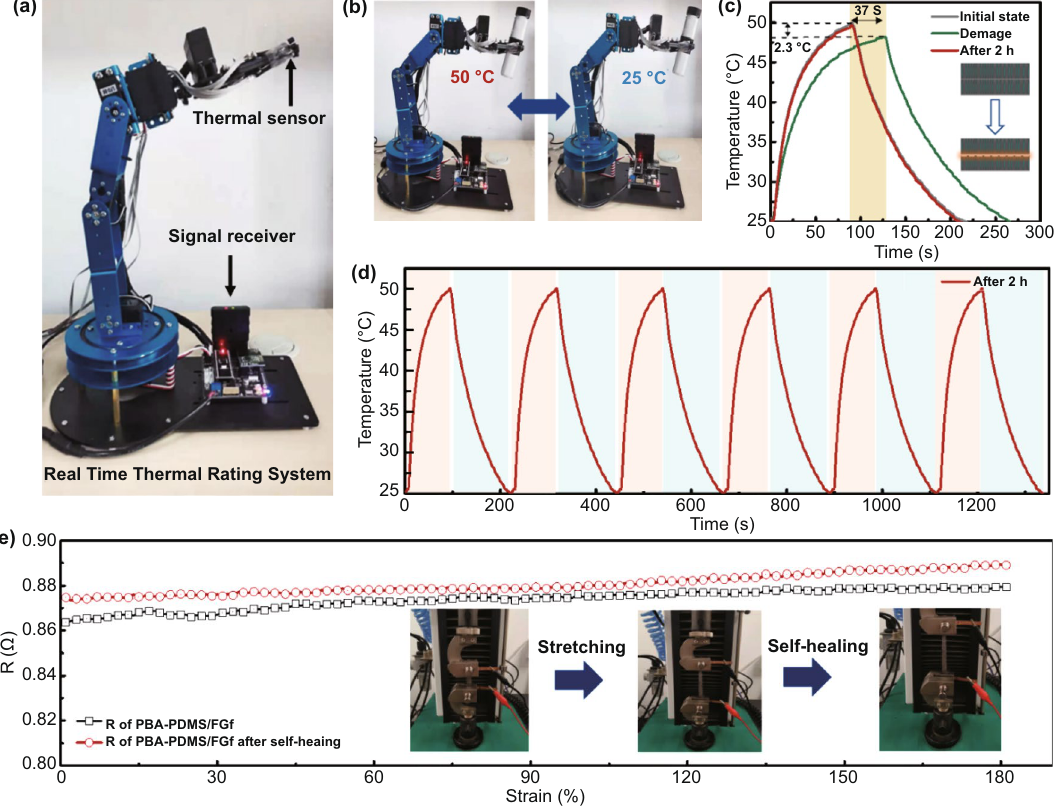
Fig. 6 a Manipulator with sensor for temperature detection. b Digital images of the manipulator grabbing hot and cold bottles. c Temperature response of the composite material before and after the manipulator self-healed and grabbed the hot and cold bottles alternately. d Temperature response curves of PBA–PDMS/FGf that underwent six self-healing cycles at room temperature for 2 h. e Resistance of PBA–PDMS/FGf before and after self-healing in the stretched